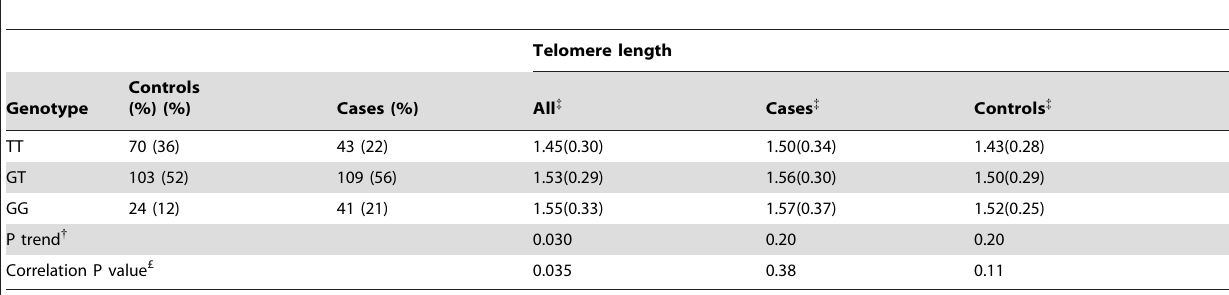
Table 3. Mean telomere length in association with rs2736100 ( CLPTM1L-TERT ), by case-control status in the Shanghai Women’s Health Study * (All cases and